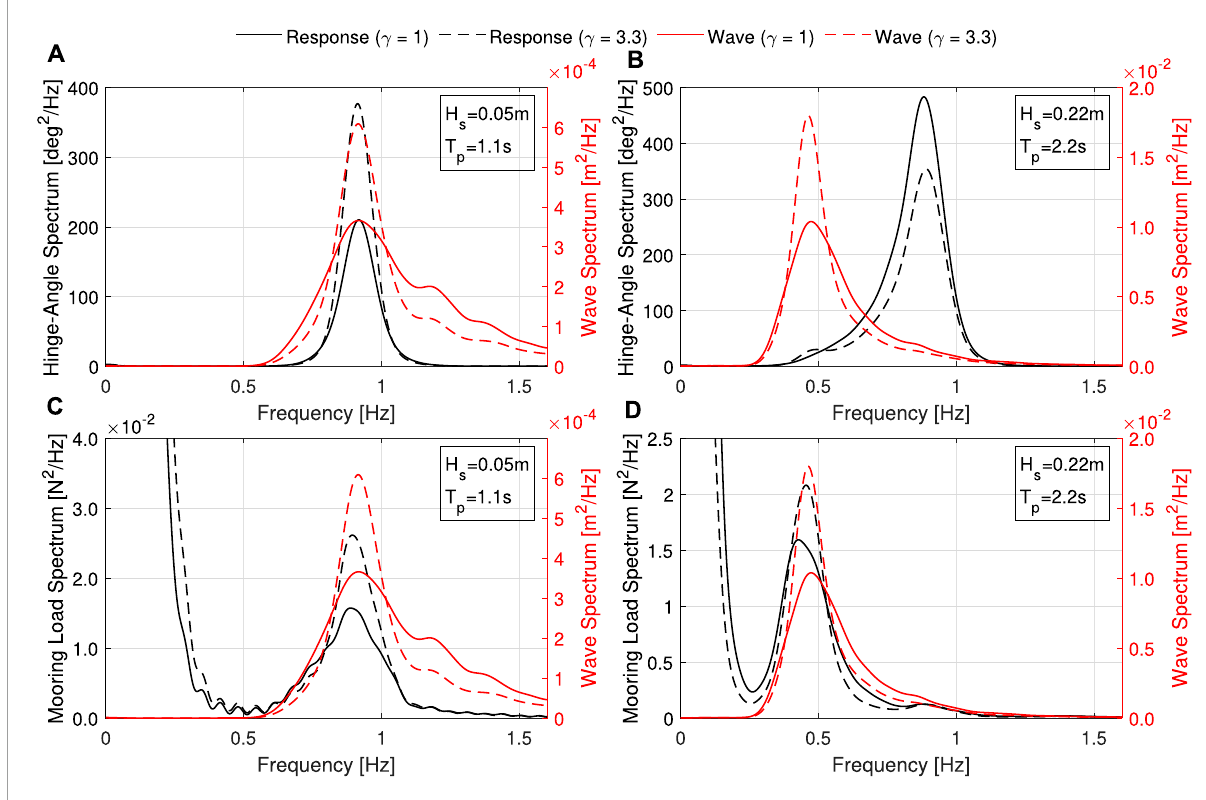
FIGURE 4 Spectral response (black) of the hinge-angle (A,B) and mooring load (C,D) compared with the incident wave spectra (red). The results for the Resonance sea state are on the left (A,C) , with the 50-year sea state on the right (B,D) . The γ value is indicated by the line style: γ = 1 (solid); and γ = 3 . 3